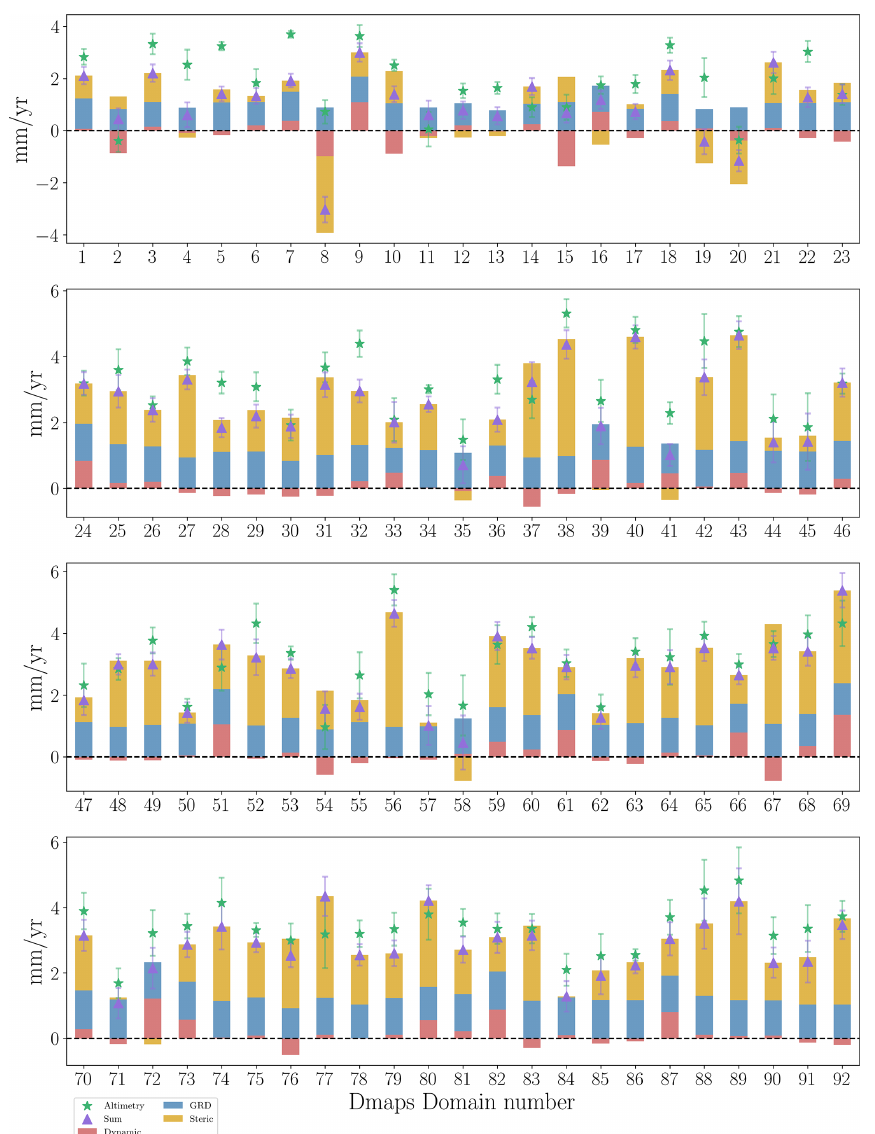
Figure A4. Extension of Fig. 4, showing the trend contribution for each of the δ -MAPS domains. An interactive budget map is available at https://carocamargo.github.io/resources/regional-SLB-domains/ (last access: 9 January 2023).